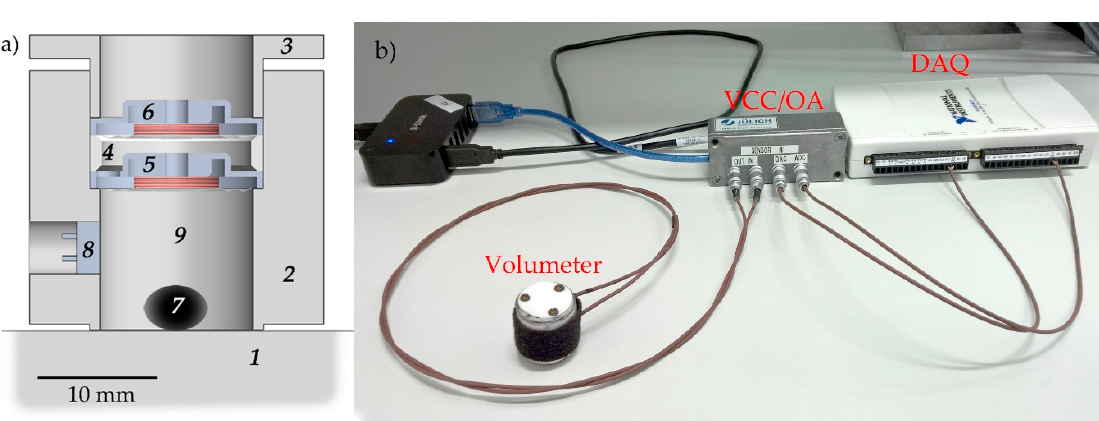
Figure 1. Schematic and image of the acoustic volumeter. ( a ) Schematic cross-section of the acoustic volumeter, which is placed on a plate 1 . 2 cylindrical housing of the sensor; 3 fixing cap; 4 washer/separation ring; 5 loudspeaker with excitation membrane; 6 dynamic microphone with detection membrane; 7 measured object; 8 additional electret microphone to compensate nonlinearities in case of measurements at different frequencies; 9 measuring chamber. ( b ) Measurement setup. The volumeter is connected to a voltage-to-current converter (VCC) and an operational amplifier (OA), which are connected to a multifunction data acquisition (DAQ) system.